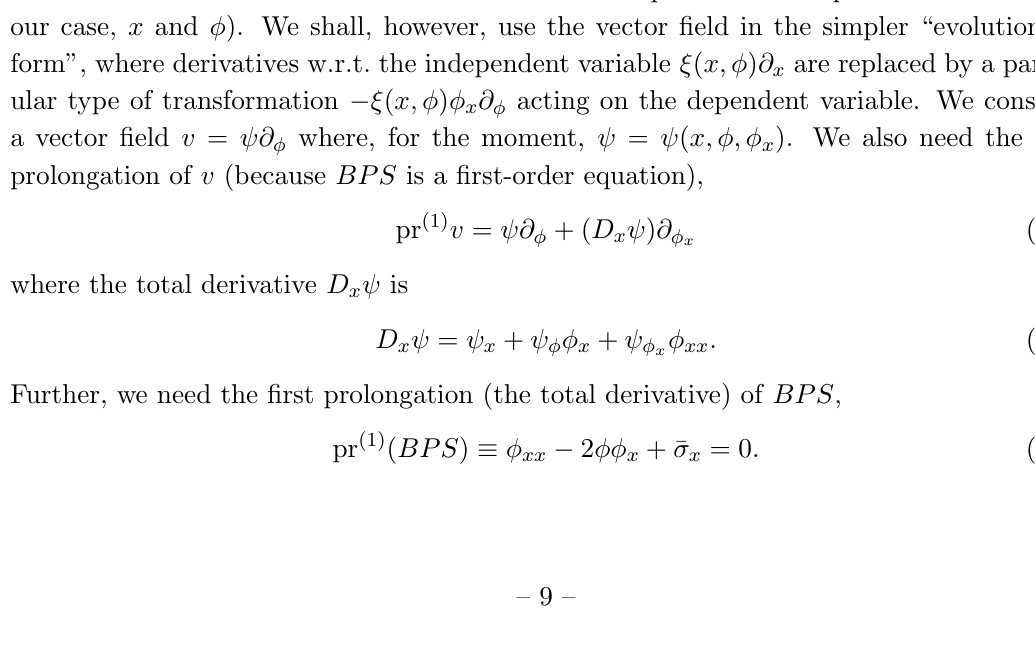
Figure 3 . The bottle-neck e(cid:11)ect of the BPS solutions for (cid:11) !